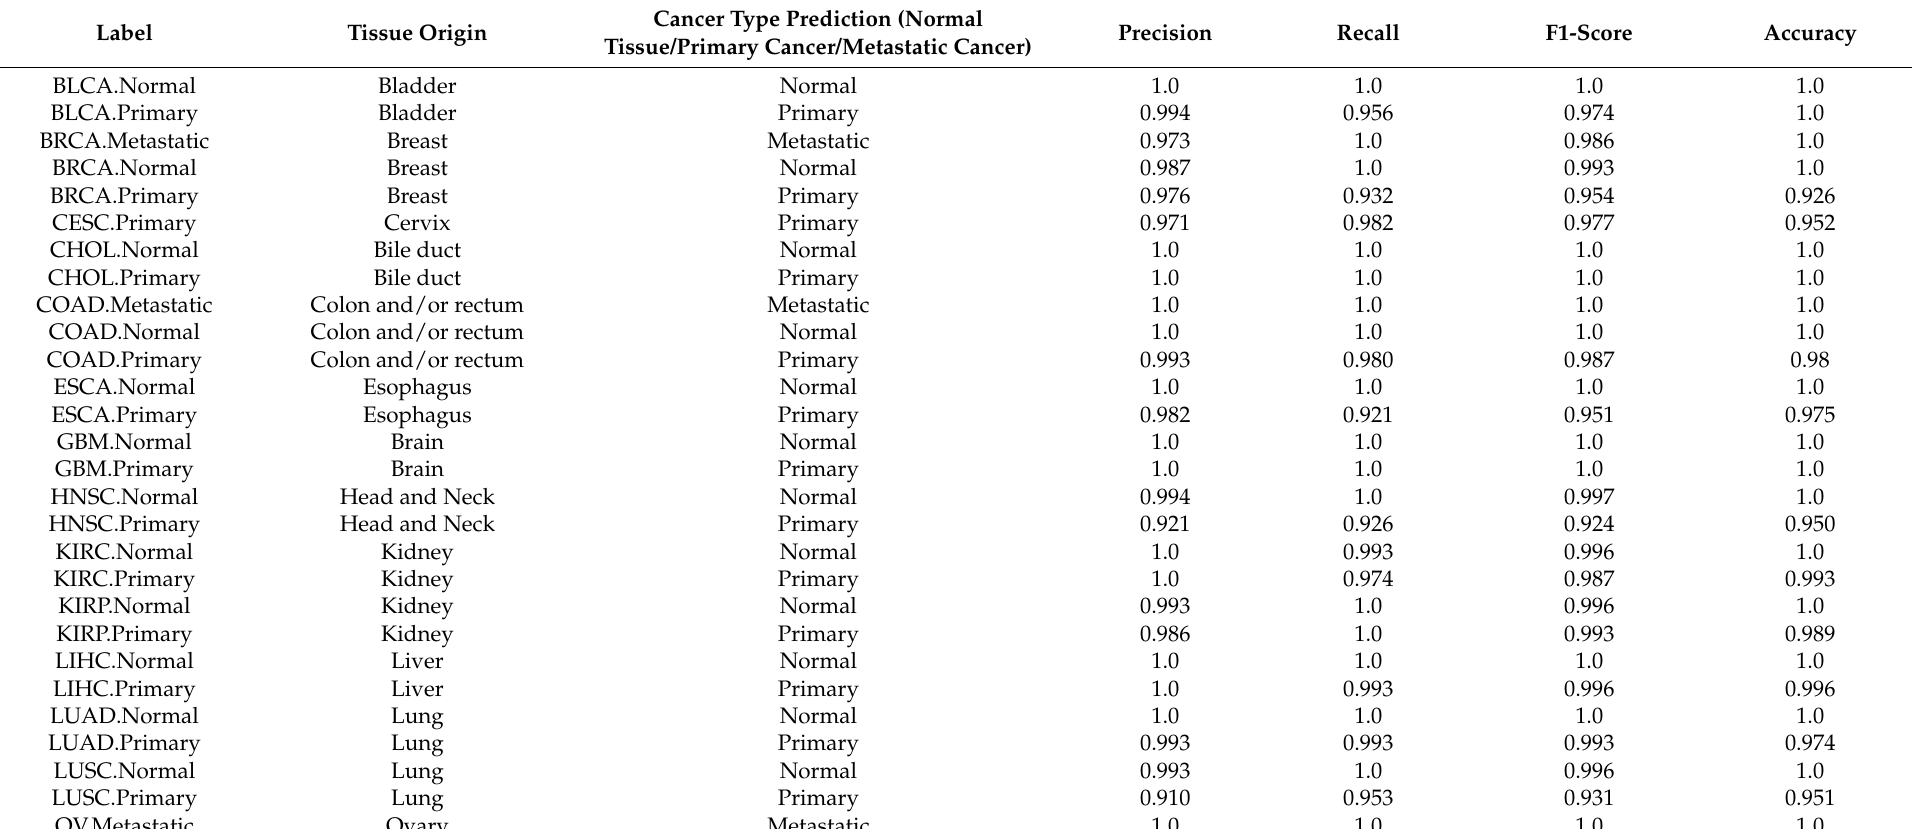
Table 1. Performance of the RF multi-label classification model after performing SMOTE for the prediction of every tissue/cancer type. Tissue/cancer type prediction, tissue origin, and labels are included in the table, along with the performance metrics. BLCA: bladder urothelial carcinoma; BRCA: breast invasive carcinoma; CESC: cervical squamous cell carcinoma and endocervical adenocarcinoma; CHOL: cholangiocarcinoma; COAD: colon adenocarcinoma; ESCA: esophageal carcinoma; GBM: glioblastoma multiforme; HNSC: head and